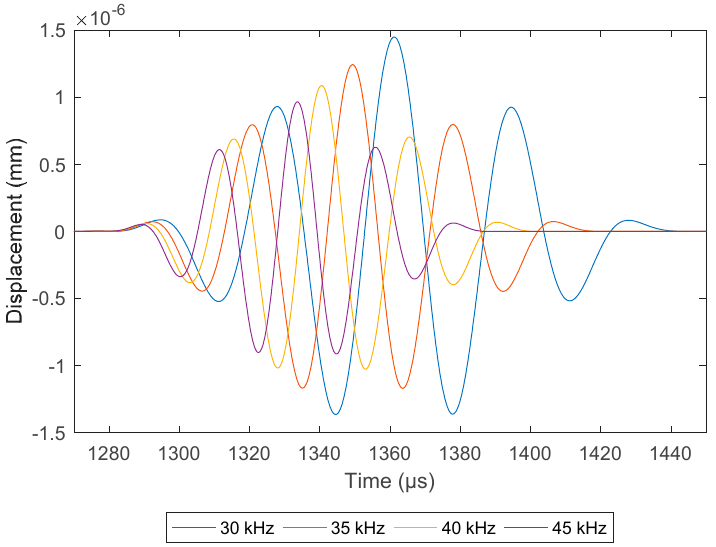
Figure 8. Comparison of FEA pitch-catch signal at different operating frequencies. Sensors 2018 , 18 , x FOR PEER REVIEW